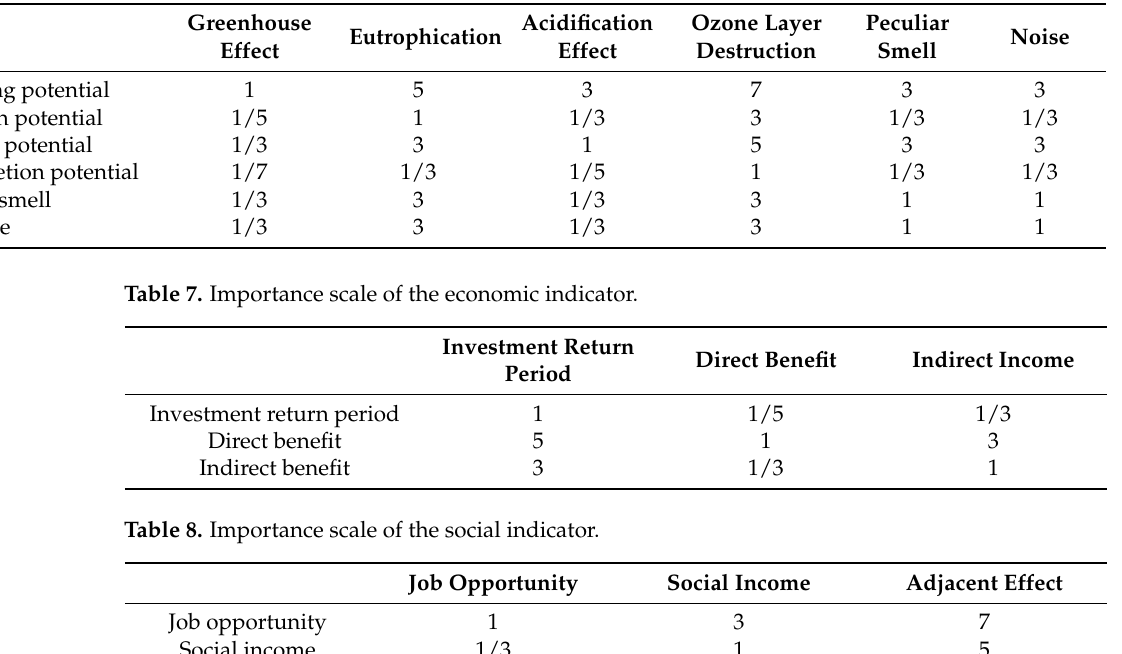
Table 6. Importance scale of the environmental indicator.